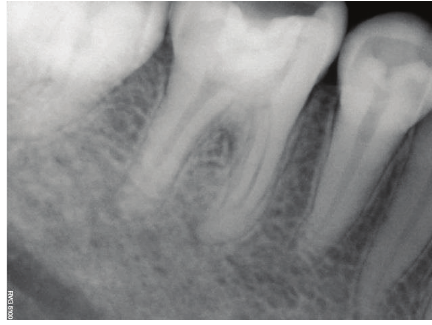
Figure 34: Platelet rich fibrin